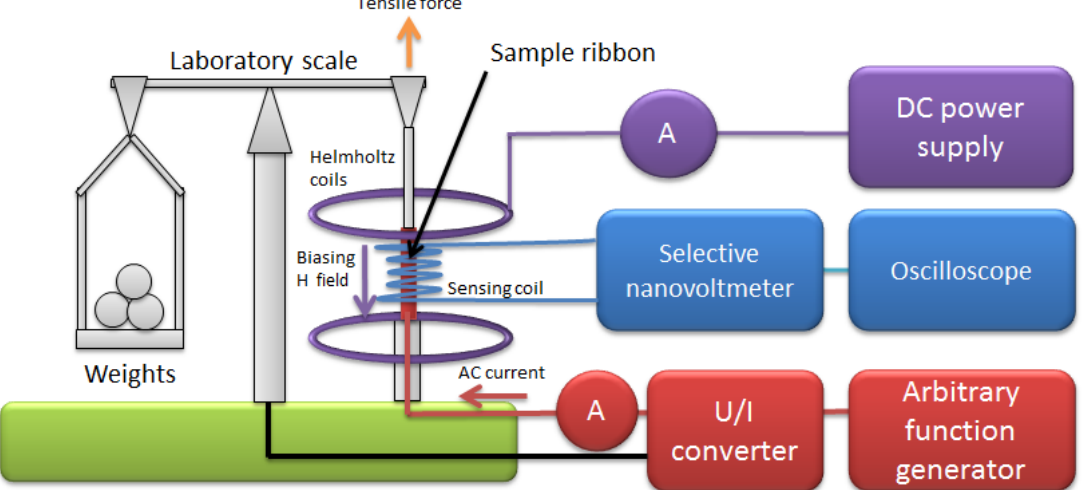
Figure 1. Schematic diagram of the developed small angle magnetization rotation (SAMR) system.